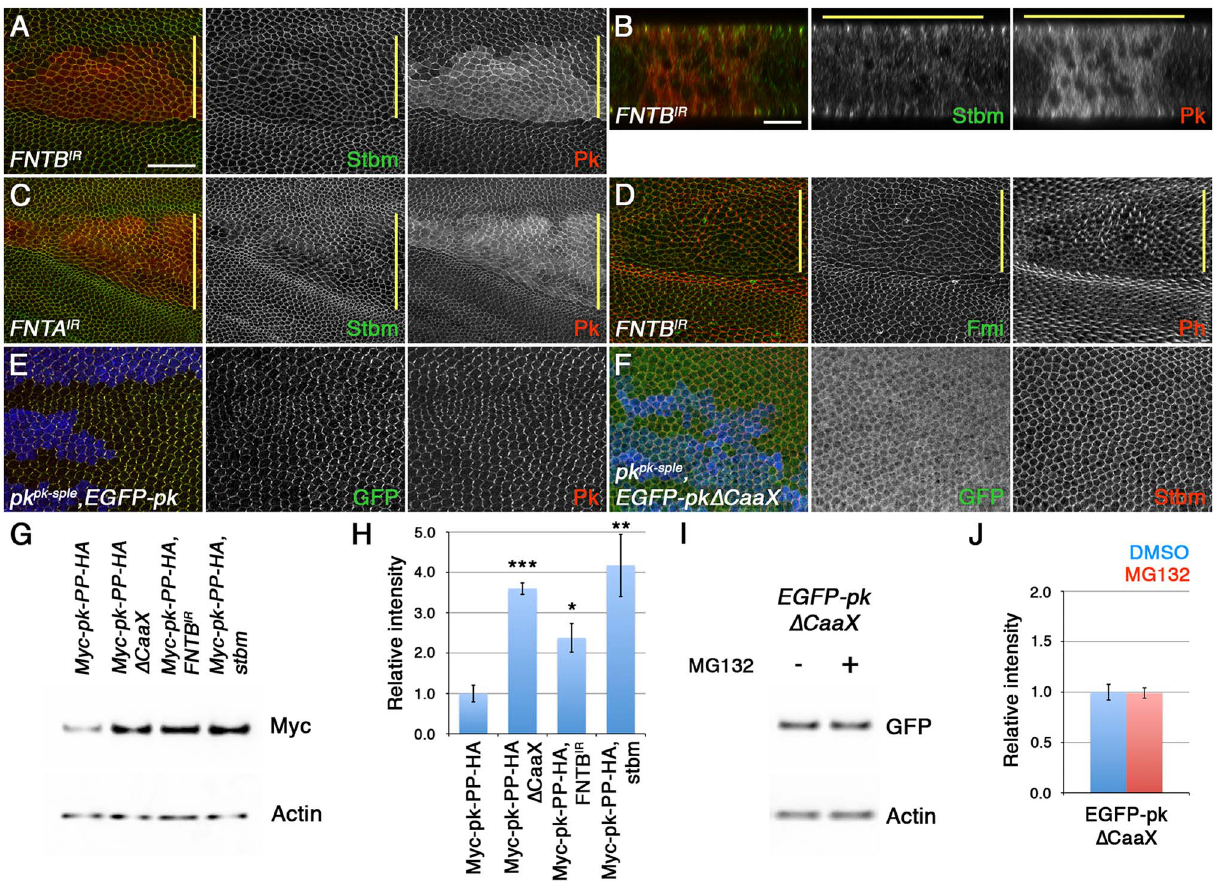
Figure 5. Loss of farnesylation causes an increase in cytoplasmic Pk. (A–D) XY (A,C,D) and XZ (B) sections of pupal wings expressing ptc- GAL4/FNTB IR-17565R-2 ; UAS-Dcr2/ + (A,B,D) or ptc-GAL4/ + ; FNTA IR-2976R-4 /UAS-Dcr2 (C). In A-C, staining is for Stbm (green) and Pk (red), and in D staining is for Fmi (green) and Phalloidin (red). (E,F) pk pk-sple13 clones, marked by loss of ß-gal staining (blue), in wings expressing ActP-EGFP-pk (E) or ActP-EGFP- pk D CaaX (F). Staining is for GFP (green) and Pk (red in E) or Stbm (red in F). Yellow bar marks the ptc-GAL4 domain. Scale bar 20 m m (A,C–F) or 10 m m (B). (G,H) Western blot (G) and quantitation (H) of Myc levels relative to Actin levels, in 28 hr pupal wings extracts from ActP-Myc-pk-PP-HA/ + , ActP- Myc-pk-PP-HA D CaaX/ + , MS1096-GAL4/w; FNTB IR-17565R-2 / + ; ActP-Myc-pk-PP-HA/ + and stbm 6 ; ActP-Myc-pk-PP-HA/ + flies. Quantitation from 3 biological replicates, error bars are s.e.m., p*** , 0.001, p** , 0.01, p* , 0.05. (I,J) Western blot (I) and quantitation (J) of GFP levels relative to Actin levels, in extracts from ActP-EGFP-pk D CaaX prepupal wings treated with 10 m M MG132, or DMSO control, for 5 hr at 25 u C. Quantitation from 2 biological replicates, error bars are s.e.m.